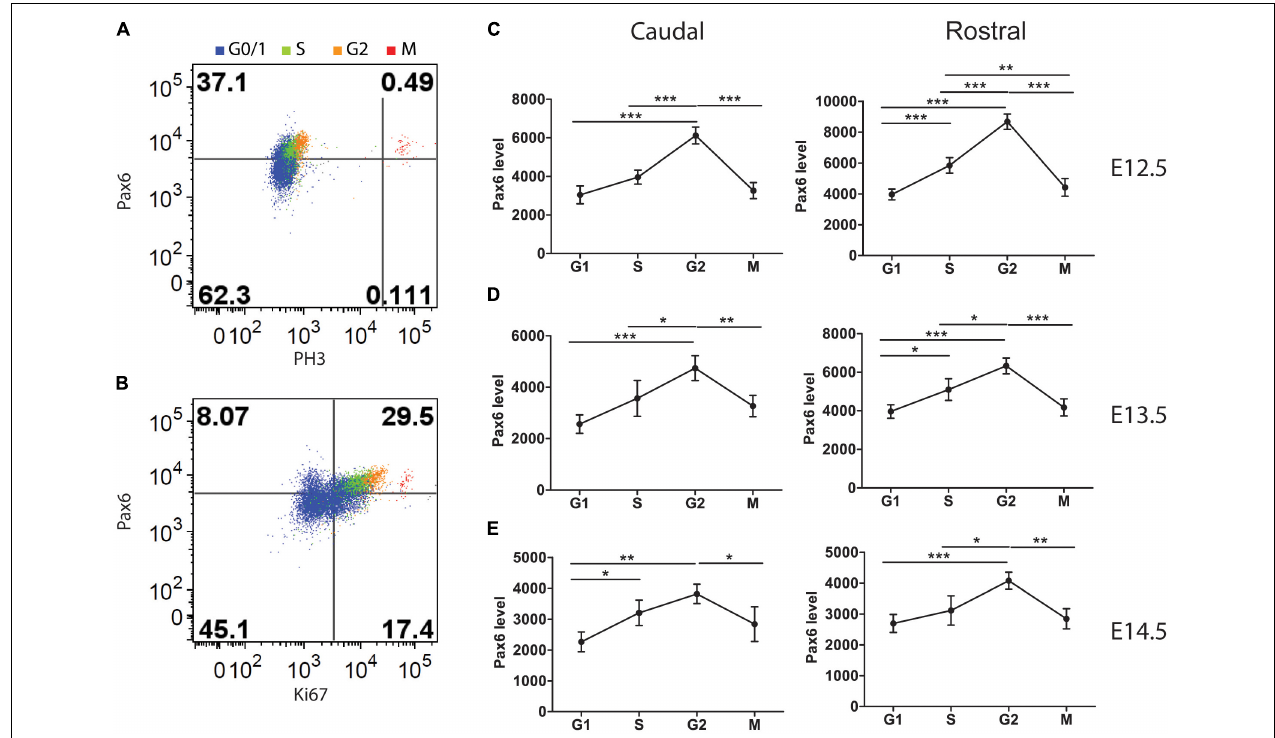
FIGURE 5 | Flow cytometric analysis of Pax6 levels at different phases of the cell cycle in Pax6 + / + cortex at E12.5, E13.5, and E14.5. Cells classified according to their cell cycle phase by methods illustrated in Figure 1 . (A) Example showing how M phase cells were identified by their expression of PH3. (B) Example showing how G1 cells were distinguished from G0 cells by positivity for Ki67. (C–E) Average relative levels ( ± SEM) of Pax6 in proliferating cortical cells (G0 cells excluded) in each cell cycle phase in rostral and caudal cortex ( n = 4 embryos at each age). ANOVAs at each age showed significant effects of cell cycle phase ( α = 0.05). Sidak’s multiple comparisons tests showed significant differences between phases, as marked ( ∗ p < 0.05; ∗∗ p < 0.001; ∗∗∗ p < 0.0001).